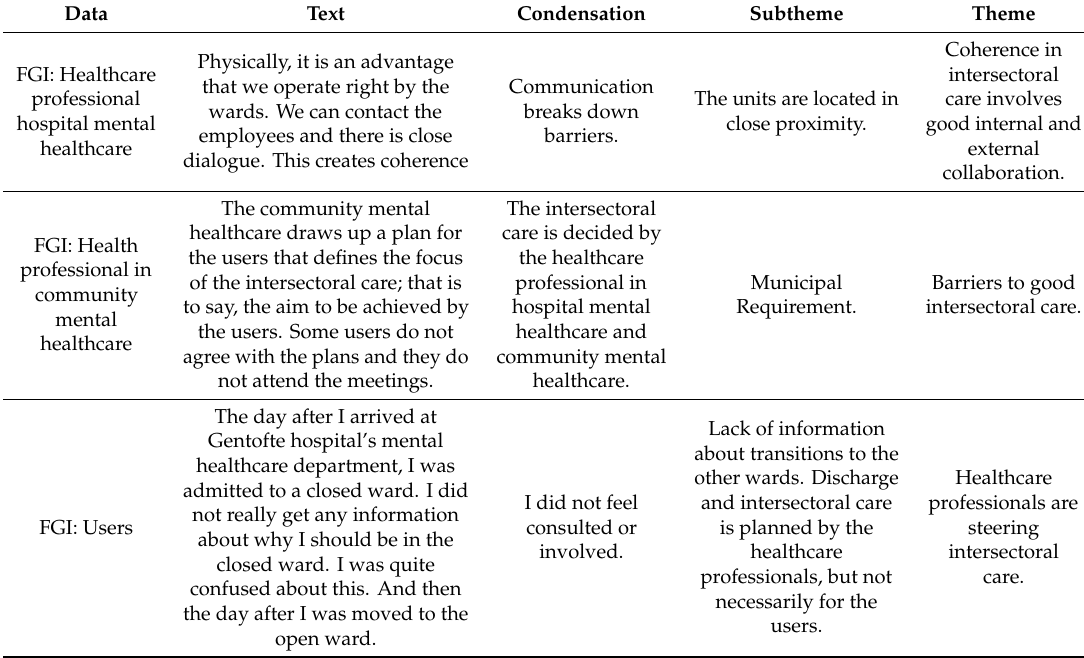
Table 3. Example of structural analysis of narrative interviews with healthcare professionals and users. Data Text